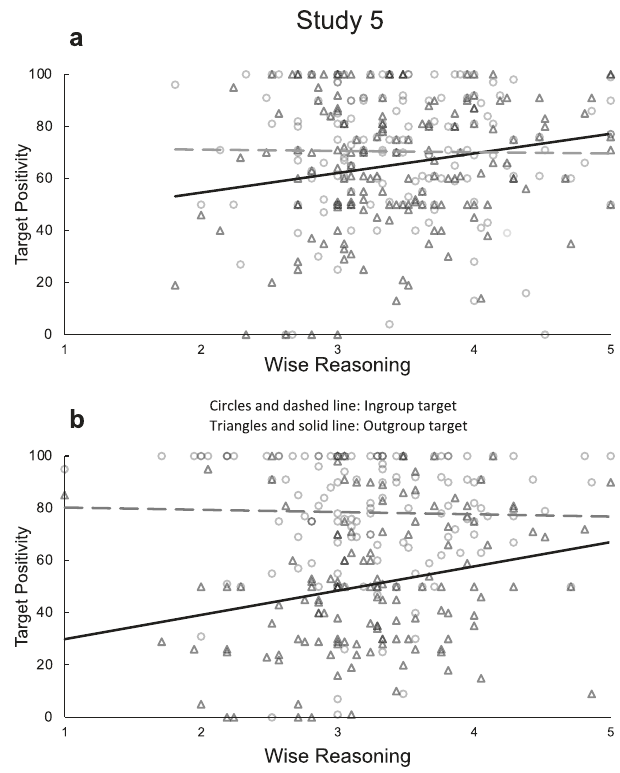
Fig. 4 Results from Study 5: within-subject positivity toward ingroup and outgroup targets in feeling thermometer as a function of self-reported group membership and their level of wise reasoning. a Christian heterosexual participants. b Lesbian, gay, or bisexual participants. M = 3.34, SD = wise reasoning